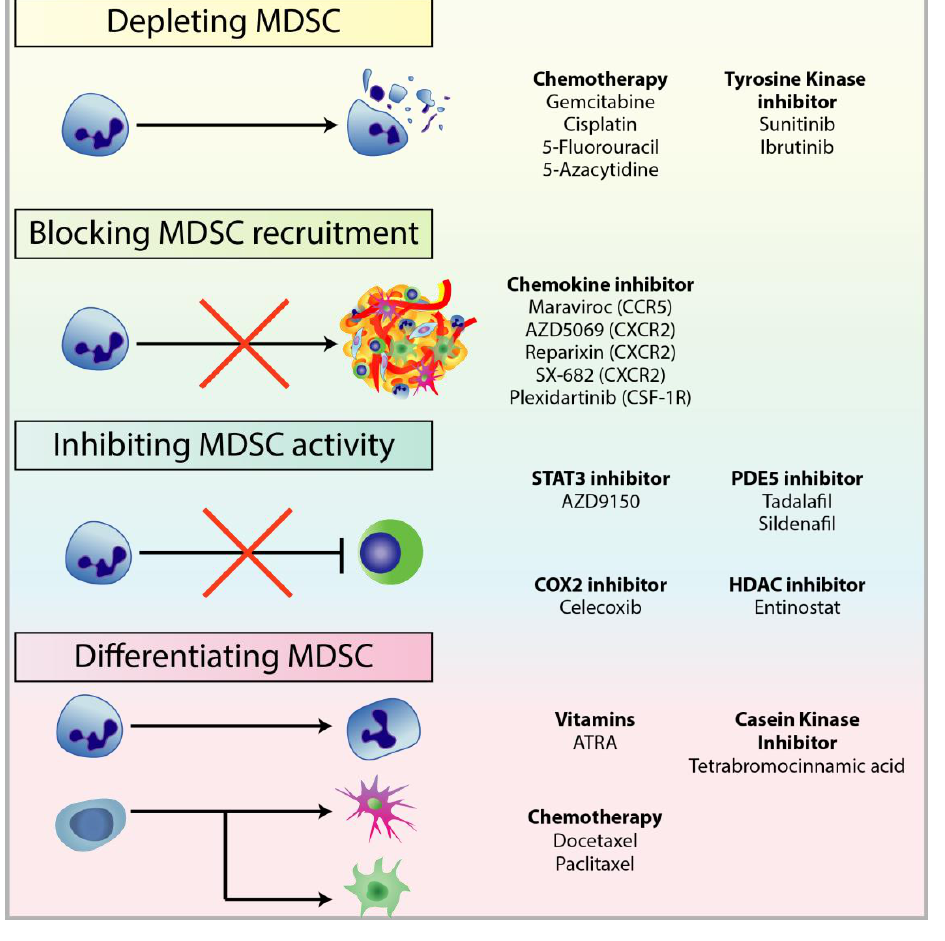
Figure 6. Treatments used to target di ff erent mechanisms associated with pro-tumourigenic